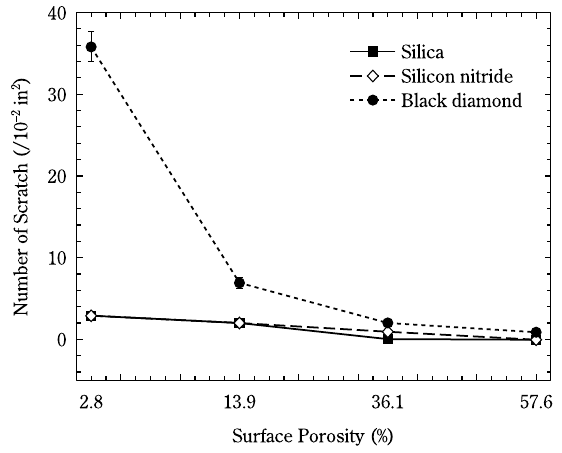
Fig. 4.2b: Change in number of scratches on black diamond, silica and silicon nitride substrates polished with 0.2 μ m silica slurry (5wt% loading, pH 3) as a function of surface porosity of silica particles (Reprinted from reference